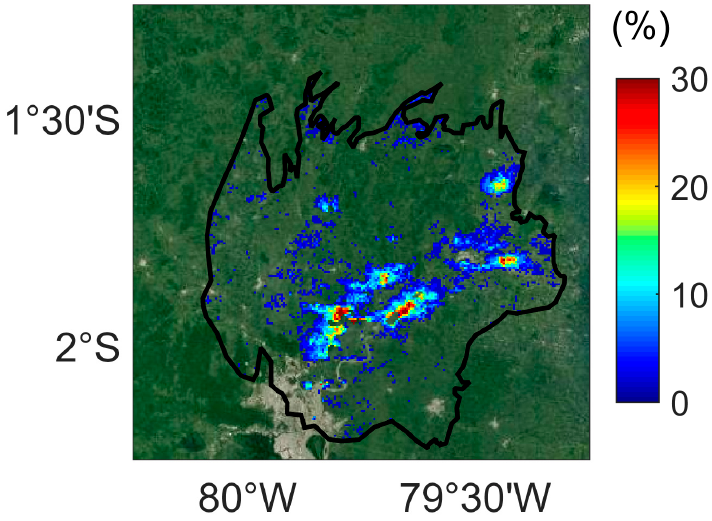
Figure 12. RFI map derived from the ASAR ‐ based inundation extent map for the − 2.30 threshold values applied to the normalized anomalies of backscattering coefficients ( γ ).